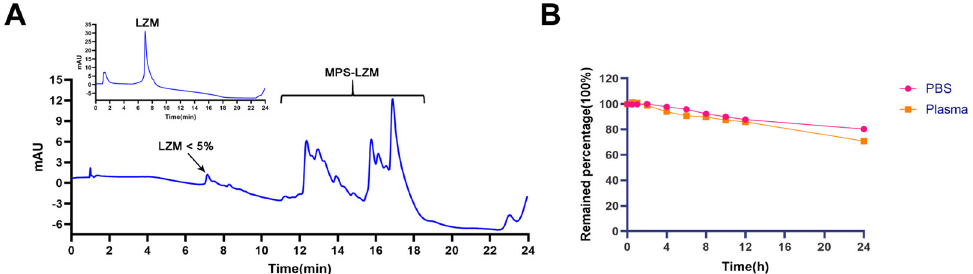
Figure 3. ( A ) Hydrophobic interaction chromatography (HIC)–HPLC analysis of MPS–LZM. HIC allowed resolution of the conjugate with LZM. LZM content is less than 5% in the conjugate; ( B ) The stability of MPS in PBS (pH 7.4) and plasma at 37 ℃ for 24 h. Data represent mean ± SD (n = 3).